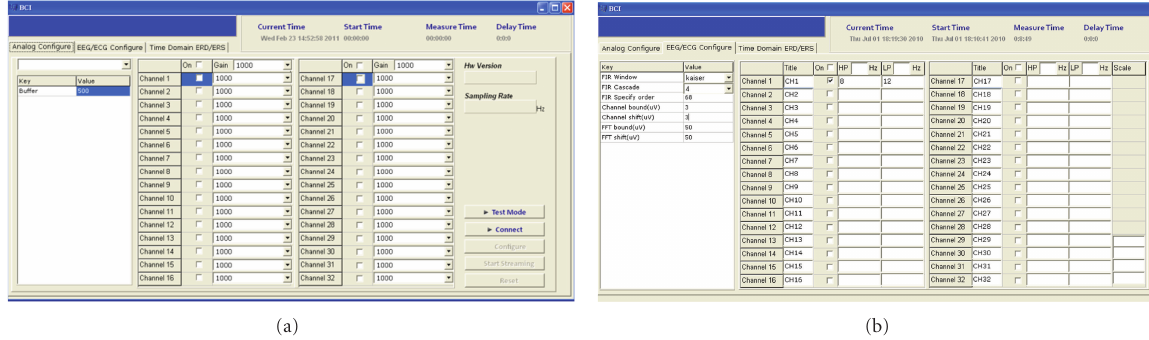
Figure 7: (a) Amplifications and band modifications. (b) Digital filters and display control.